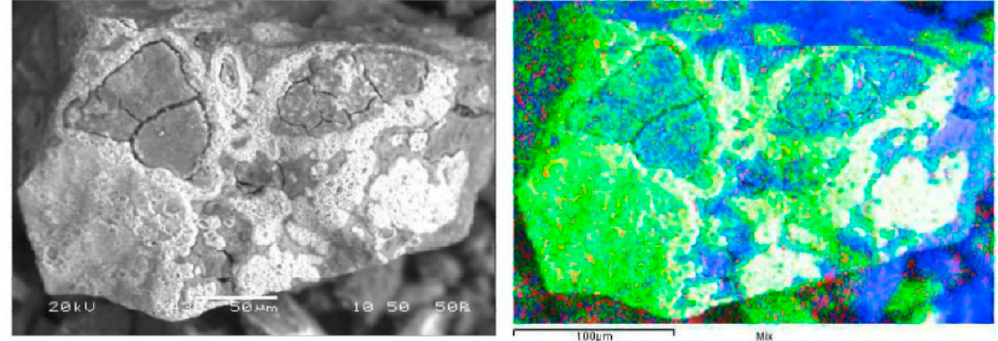
Figure 11. SEM image shows RA residues obtained under reducing conditions using FeSO 4 . Manganese (green), copper (red) and silica (blue).